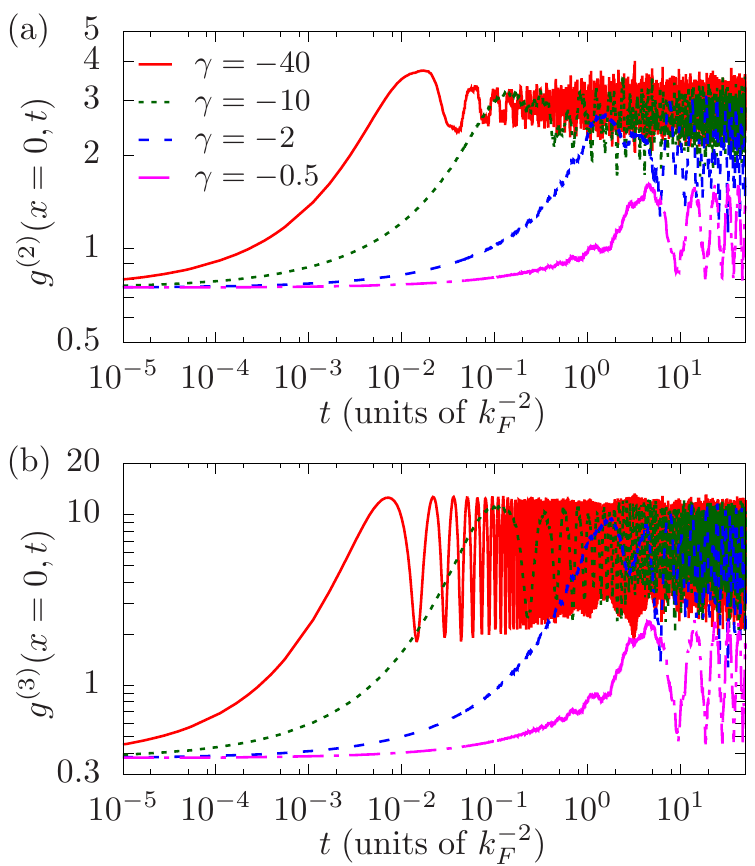
Figure 5: Time evolution of local correlation functions following quenches of the interaction strength from zero to γ = − 0.5, − 2, − 10 and − 40 for N = 4 particles. (a) Local second-order correlation g ( 2 ) ( x = 0, t ) . (b) Local third-order correlation g ( 3 ) ( x = 0, t ) . ticular, the number of eigenstates with populations | C { λ